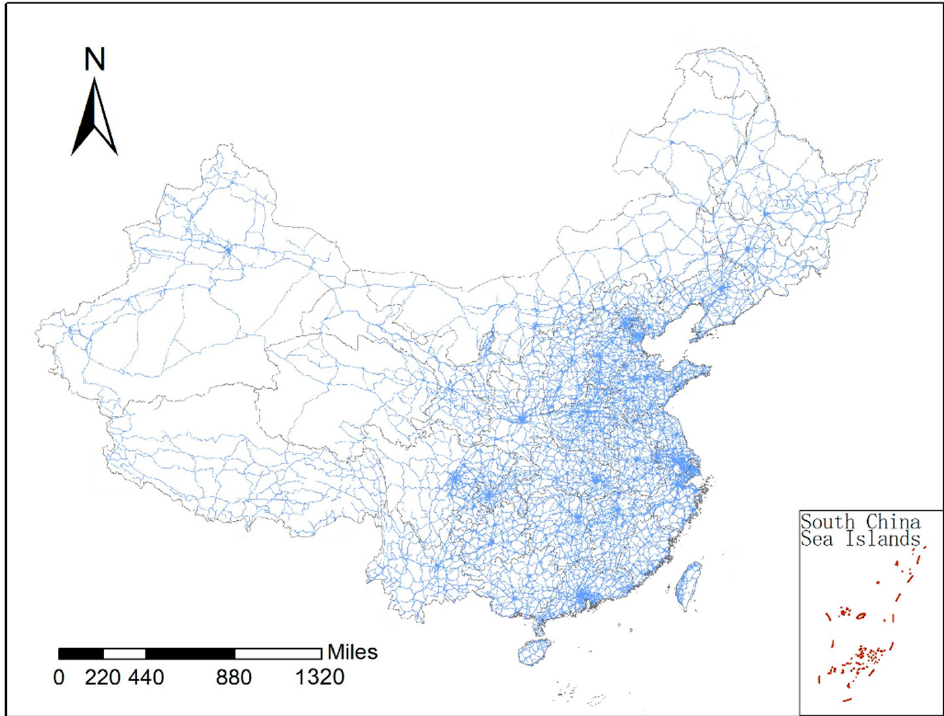
Figure 2. Schematic diagram of main expressways, national and provincial highways in China.